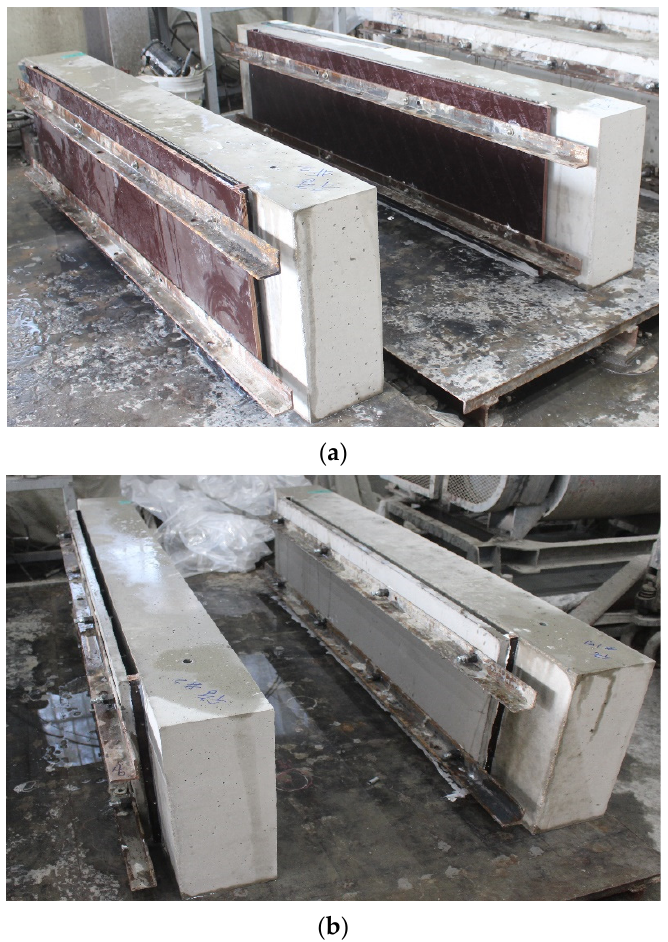
Figure 9. Fabrication of RC slab specimens with TRC grouting system: ( a ) CUW series; ( b ) PUW series.